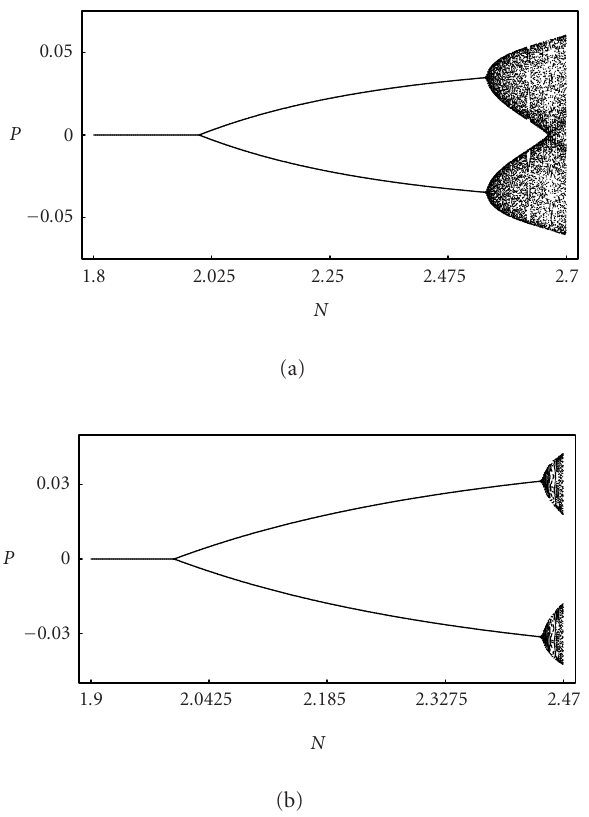
Figure 4.1. Robustness of the dynamics. The panel in (a) shows a bifurcation diagram for the model with the technical trading rule (4.1). In (b), the technical trading rule (4.2) is used. The parameter N is increased as indicated on the axis. The remaining setup is as in Figure